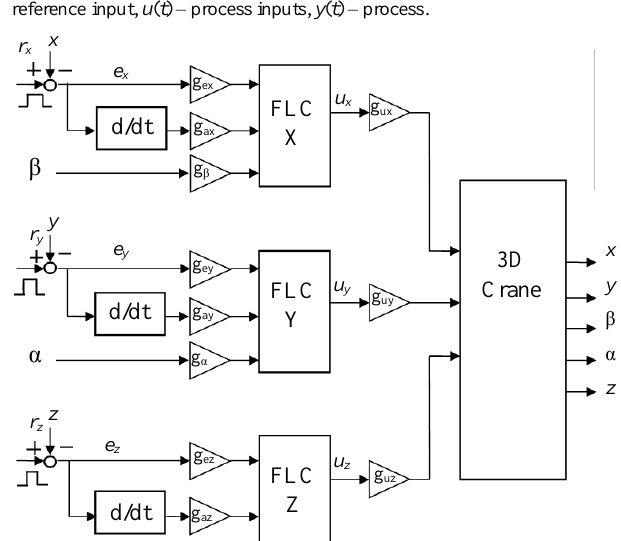
Fig. 4. Fuzzy logic controller block diagram: FLC – fuzzy logic controller, r ( t ) – reference input, u ( t ) – process inputs, y ( t ) – process.